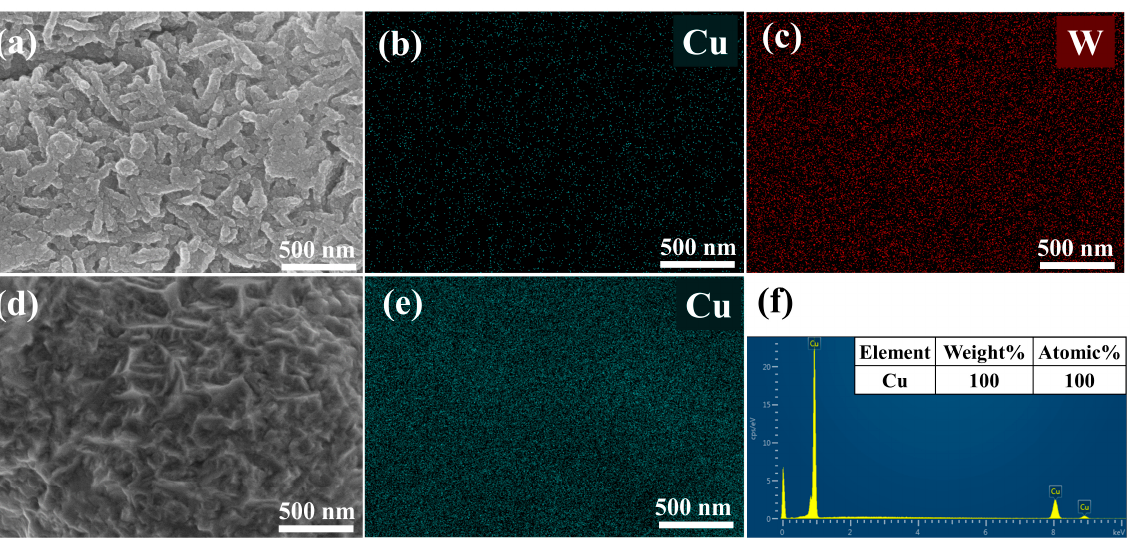
Figure 5. SEM images of the surface morphology and the corresponding EDS results of Cu plating for ( a ) 1 min; ( b ) and ( c ) elemental mapping in ( a ); ( d ) 30 min; ( e ) element mapping and ( f ) EDS results in ( d ).